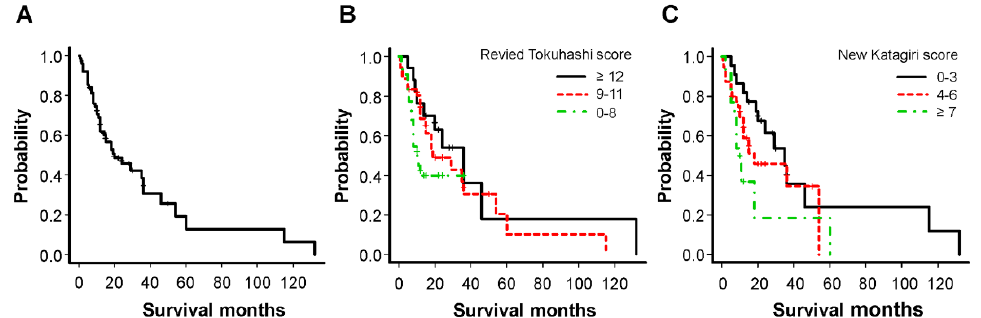
Figure 1. Kaplan − Meier analyses of overall survival after palliative surgery in all patients ( A ) and